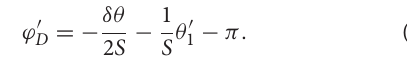
FIGURE 8 | Static director fields around matching and mismatching defect pairs obtained by Equation (9) (top) with δθ homogeneous external director field indicated by the pink arrow below the plots. The red dot marks the shows their appearance between crossed polarizers with diagonal phase plate. The image was reproduced from Missaoui et al. [